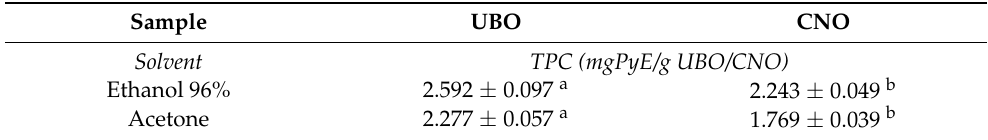
Table 5. Total phenolic content in UBO and